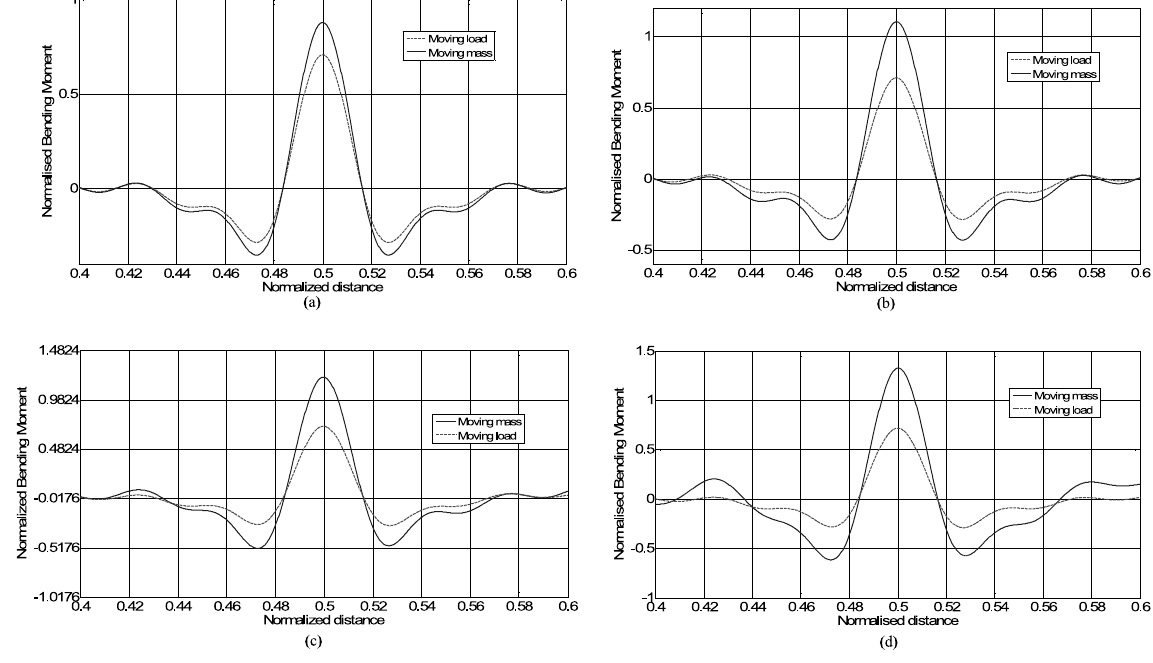
Fig. 6. Normalized bending moment responses with different velocity ratios; (a) velocity ratio = 0.025; (b) velocity ratio = 0.05; (c) velocity ratio = 0.075; (d) velocity ratio =